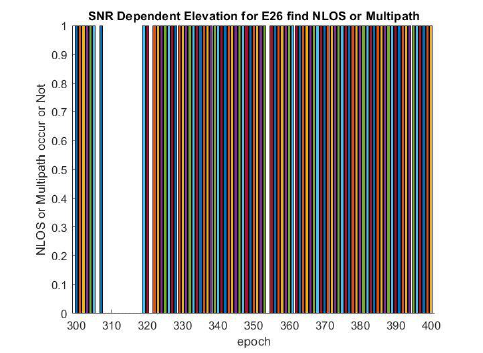
Figure 14. SNR Dependent Elevation find NLOS or Multipath Figure 11. CMCD find NLOS or Multipath for G13 for E26 ( In this figure, if multipath or NLOS detected bar shows 1, and ( In this figure, if multipath or NLOS detected bar shows 1, and if not shows 0. Also in this figure colors do not have special if not shows 0. Also in this figure colors do not have special meaning. ) meaning. )